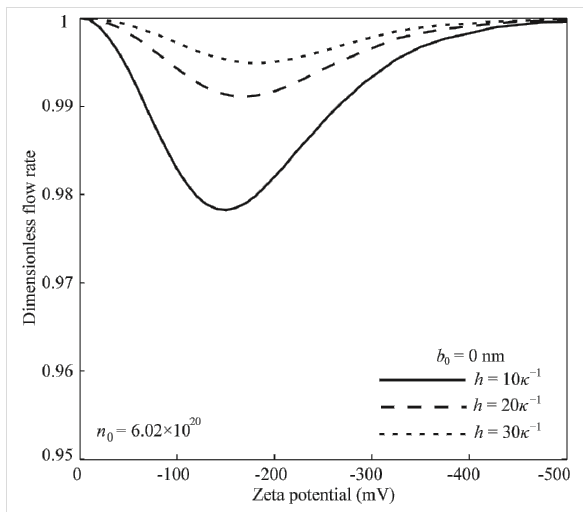
Figure 6: The effect of EDL with high zeta potential on the flow rate of the pressure-driven flow in the microchannel with no-slip condition.